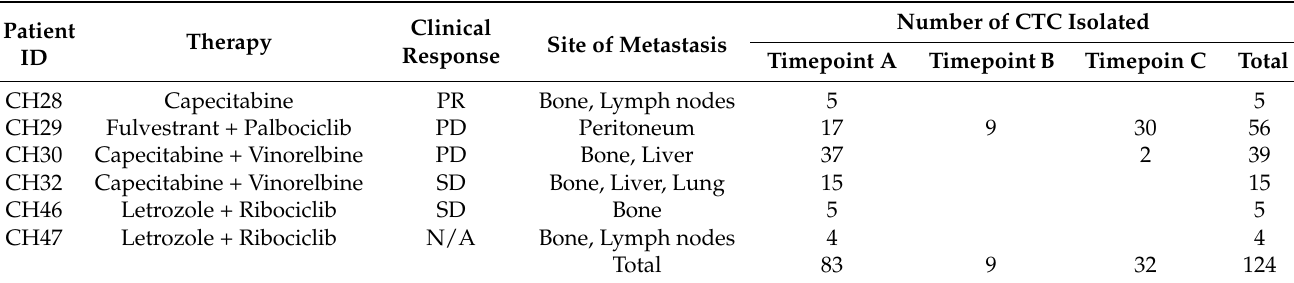
Table 1. List of patients with clinical parameters and number of single CTCs for each patient and